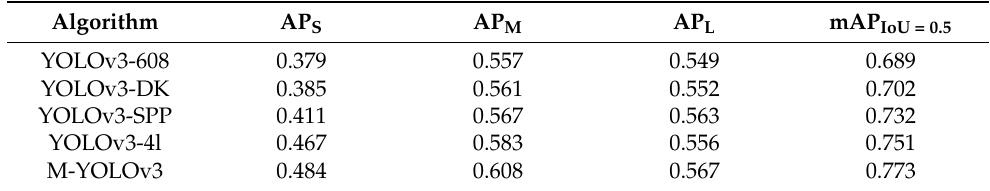
Table 1. Comparison of the improved YOLOv3 algorithm.